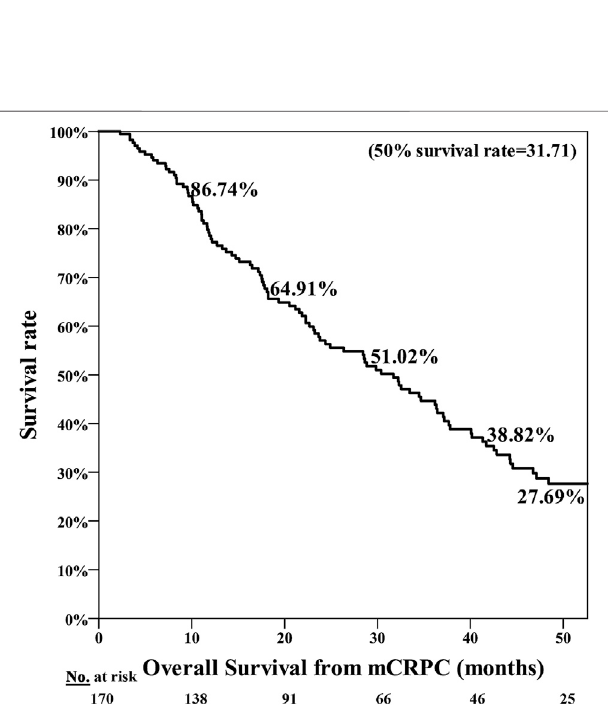
FIGURE 4 | Overall Survival (OS) for mCRPC patients treated with docetaxel for a median 31.71 months.